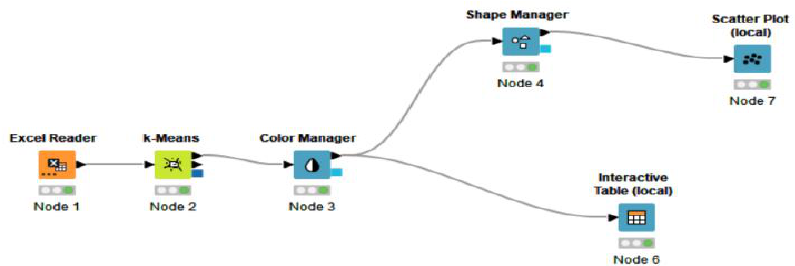
Figure 7. KNIME software elements (nodes) in the workflow regarding health indicators. Source: authors’ compilation in KNIME Analytics Platform.